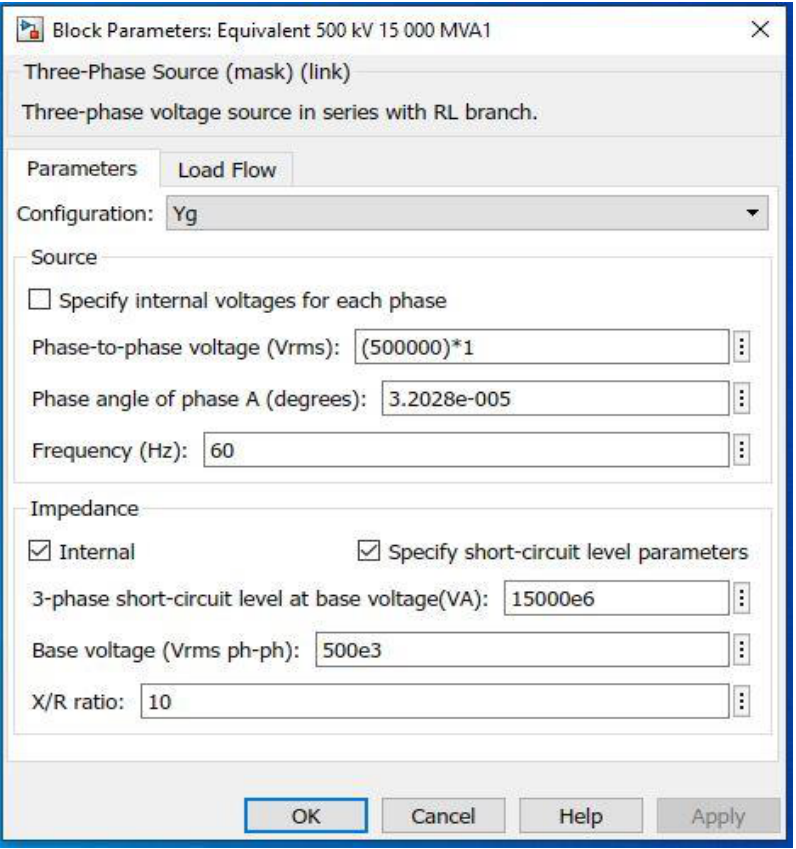
Figure 14. Parameters setting of 1000 MW Wind Farm Block.